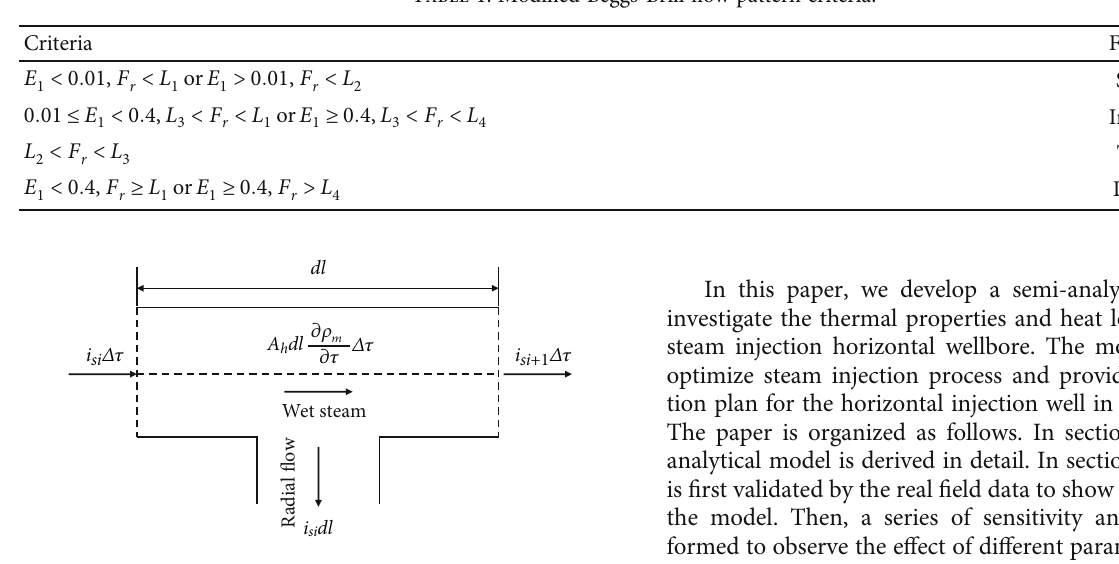
Figure 1: Schematic fi gure of mass conservation in an in fi nitesimal